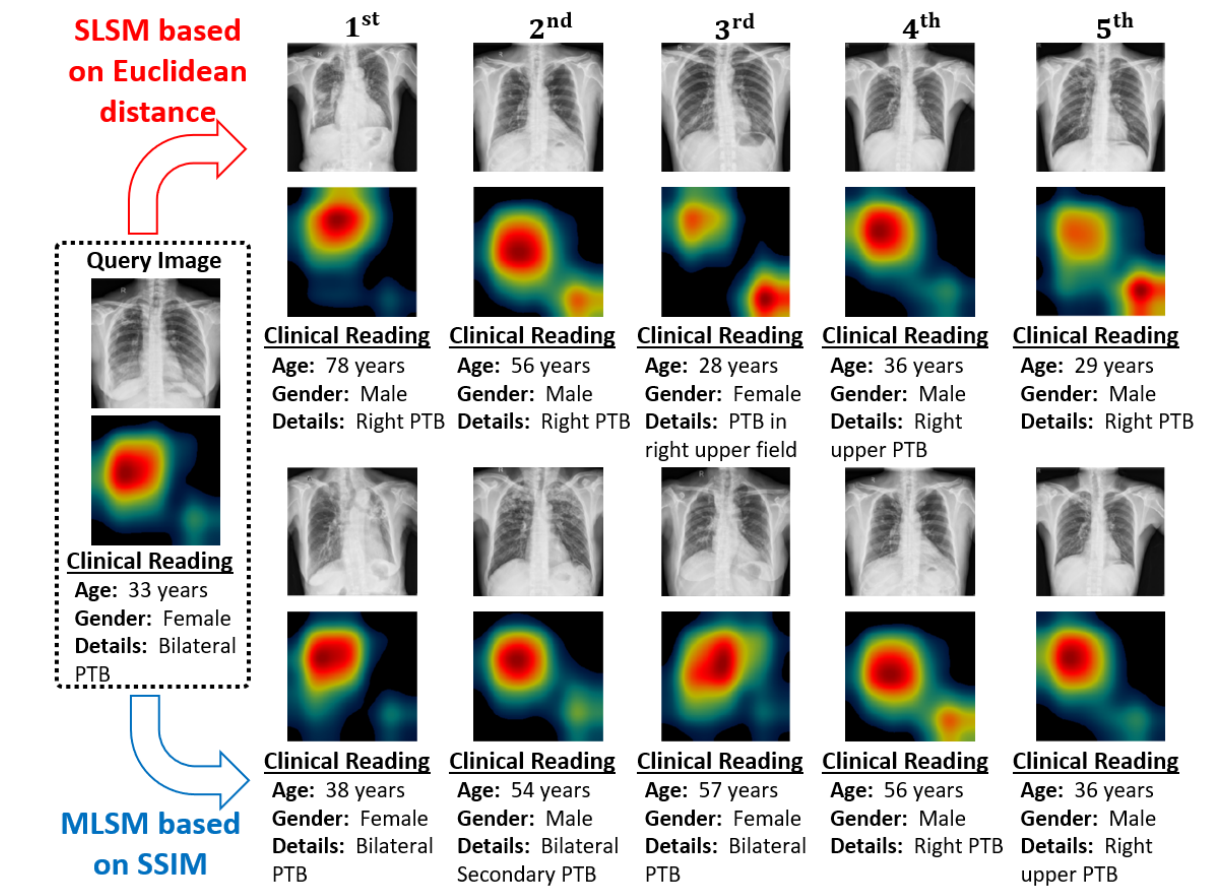
Figure 8. Visualization of retrieval performance for the given input query image by considering SLSM and MLSM (our proposed model). MLSM: multilevel similarity measure; SLSM: single-level similarity